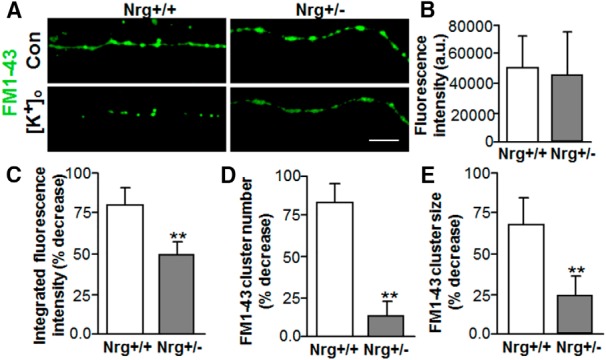
Reduced presynaptic type III Nrg1 signaling decreases depolarization-induced FM1-43 destaining along vHipp axons. Cultures of vHipp microslices from WT (Nrg+/+) or heterozygous (Nrg+/−) mice were loaded with FM1-43. Representative micrographs of WT (Nrg+/+; A, left) and Nrg+/− (A, right) vHipp axons (loaded with FM1-43, green) before (A, top) and after (A, bottom) depolarization with elevated extracellular K+ are shown. Scale bar, 10μm. B, Bar graph showed no difference in the initial FM1-43 fluorescence intensities after K+-dependent loading between +/+ and +/− vHipp axons. The efficacy of depolarization in eliciting release was assayed from determinations of FM1-43 staining including measures of the % decrease with depolarization as well as any differences in the number and/or size of the FM1-43 clusters (C--E). C, The overall FM1-43 fluorescence intensity decreased along vHipp axons after depolarization in both Nrg+/+ and Nrg+/− vHipp axons, the magnitude of the effect is significantly lower for the Nrg+/− vHipp axons compared with control whether assessed as the percentage of total fluorescence intensity (C) or the percentage decrease in cluster number (D) or in the size of the FM1-43 clusters (E). Bar graphs of mean ± SEM of eight independent experiments. The effect of depolarization on transmitter release (assayed as FM1-43 destaining) significantly depressed in the Nrg+/− vHipp compared with the Nrg+/+ controls (**p < 0.01).